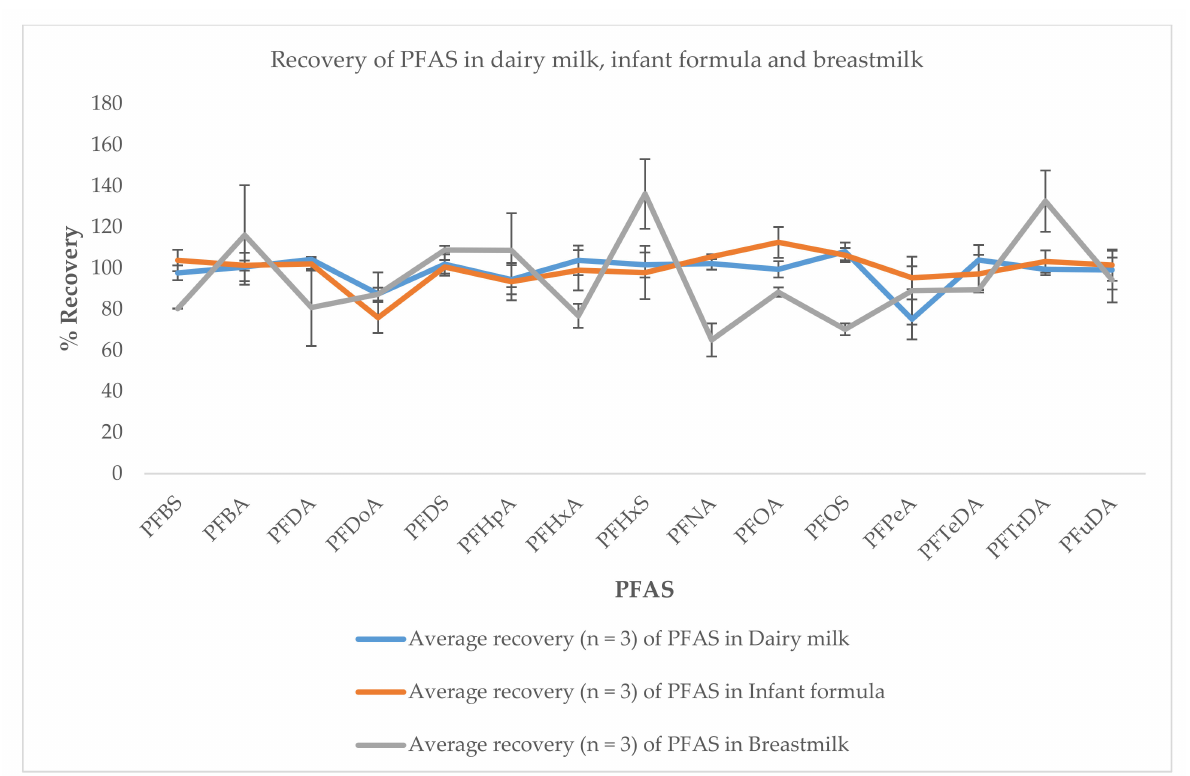
Figure 5. Recovery of PFAS in dairy milk, infant formula and